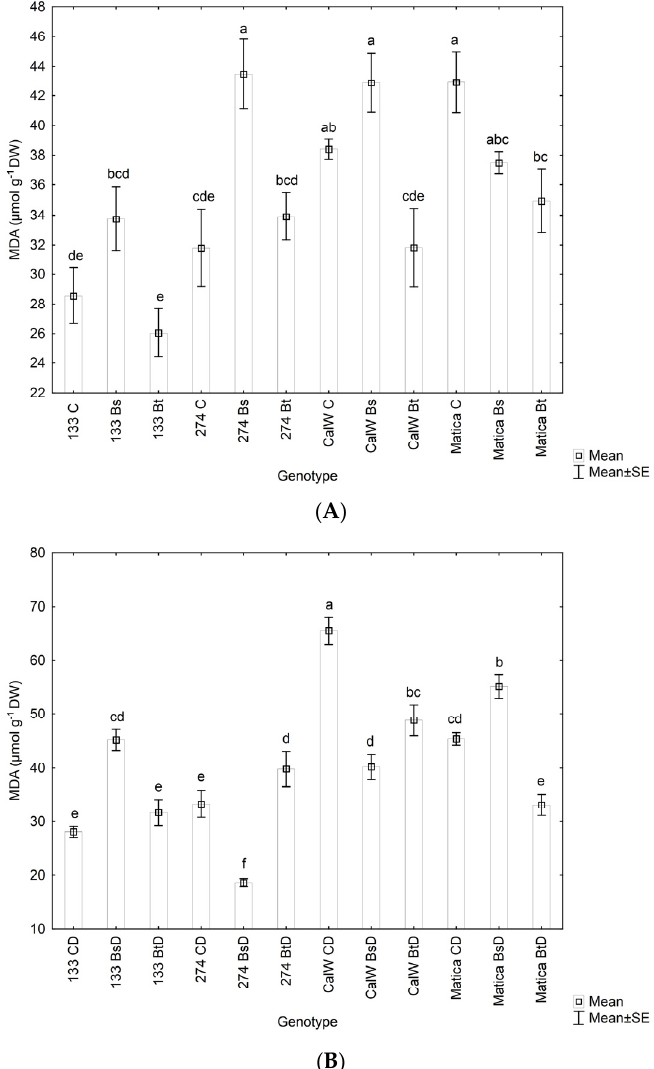
Figure 4. MDA content in leaves of 133, 274, CalW, and Matica genotypes in ( A ) control (C) and ( B ) drought (D) conditions treated with two bacterial strains, B. safensis SS-2.7—Bs and B. thuringiensis SS-29.2—Bt. Different letters show significant differences between genotypes ( p < 0.05) according to Duncan’s test.